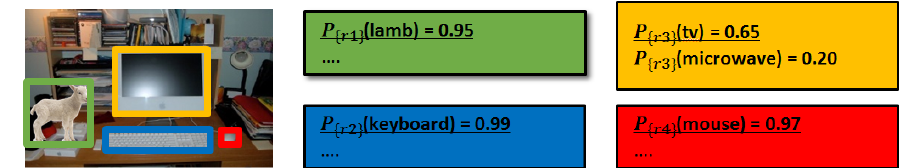
Figure 7. Step 1. Extract object region and calculate category score using the object detector such as the faster region-based convolutional neural network (R-CNN) [32].